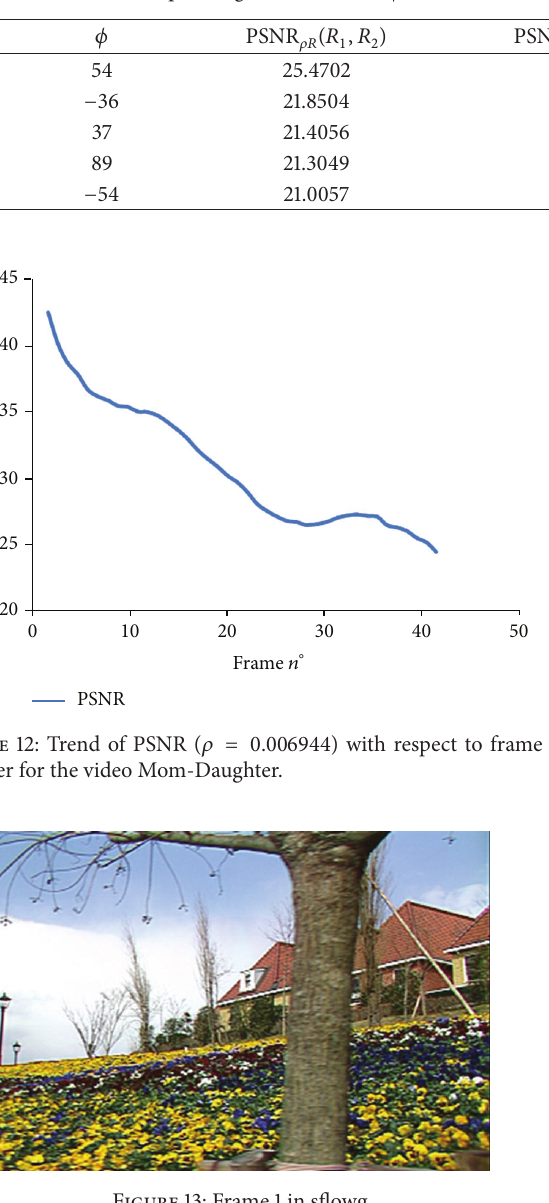
Figure 13: Frame 1 in sflowg.